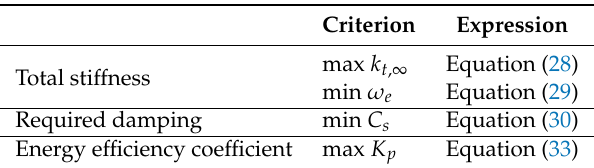
Table 2. Performance